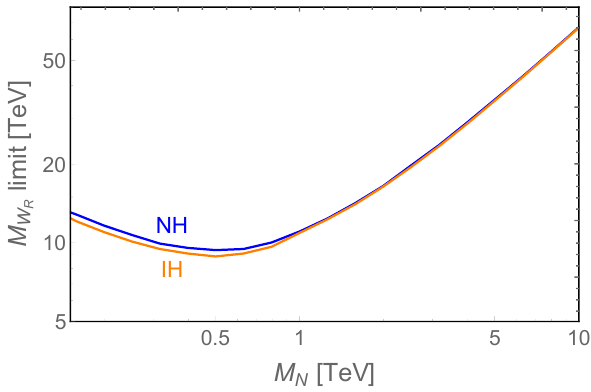
Figure 9. Leptogenesis constraint on W R mass in the case with only two quasi-degenerate RHNs, as function of the average RHN mass M N . The blue and orange curves are respectively for the NH and IH cases. The regions below the curves are